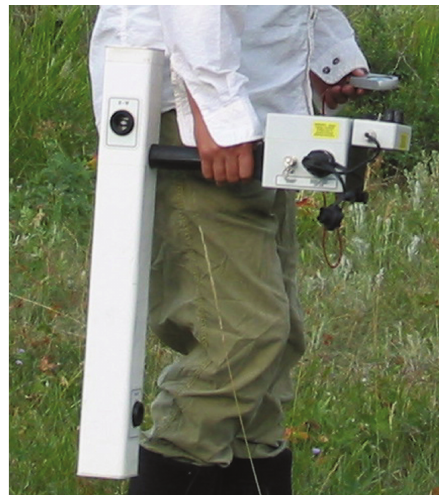
Figure 2: FM36 Magnetic Gradiometer by Geoscan Research (Bradford, West Yorkshire, UK). This handheld device is used to scan for subsurface archaeological